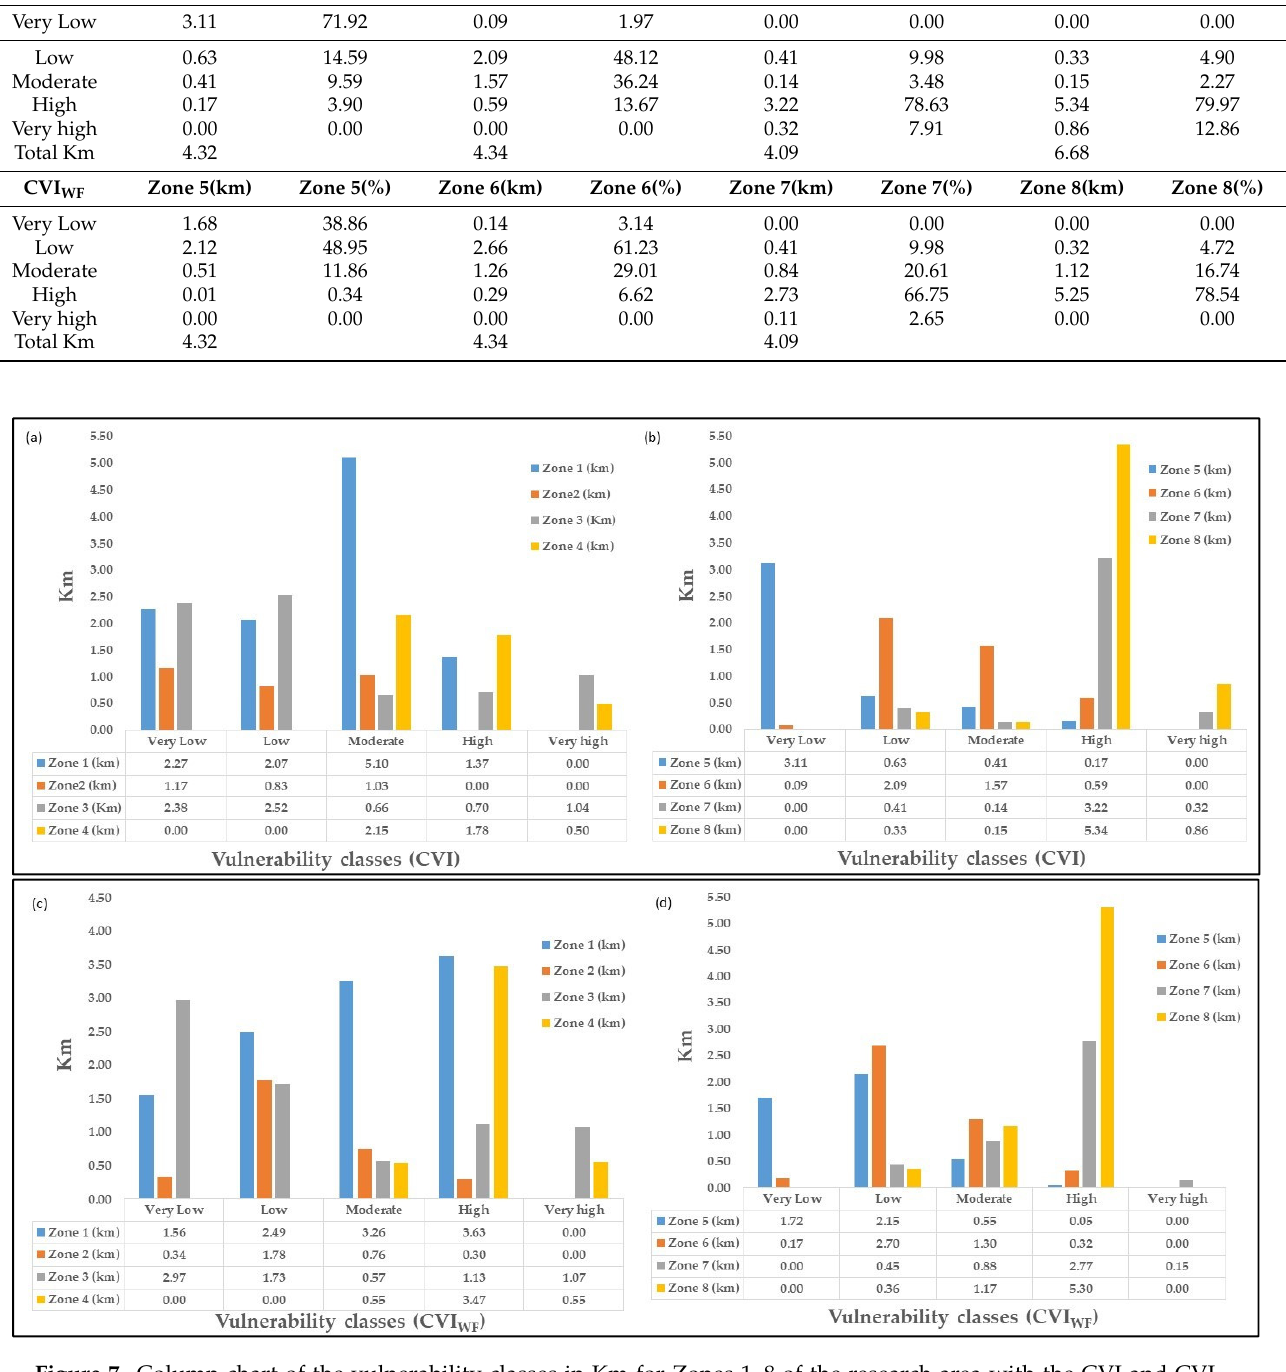
Figure 7. Column chart of the vulnerability classes in Km for Zones 1–8 of the research area with the CVI and CVI wf applications: ( a ) CVI classes in Zones 1-4, ( b ) CVI classes in Zones 5-8, ( c ) CVI wf classes in Zones 1–4, ( d ) CVI wf classes in Zones 5–8.